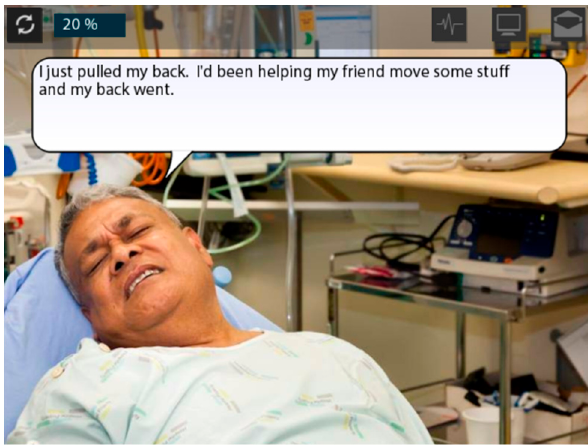
Figure 1. Part I of “Ready to Practice?” (R2P): communicating with the patient.